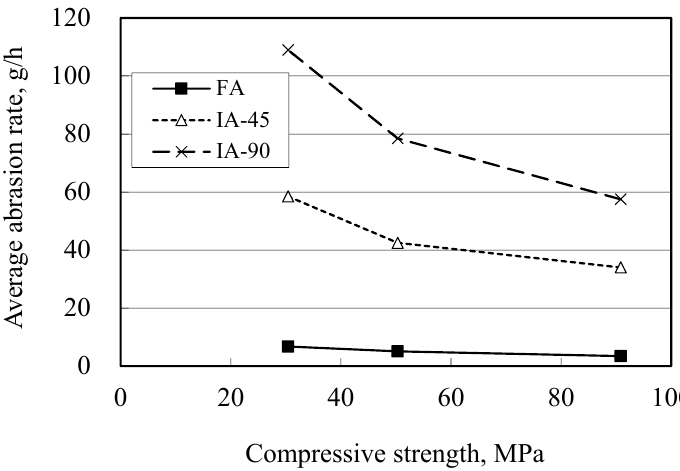
Figure 14. Relationship between average abrasion rate and compressive strength of concrete without steel fiber.